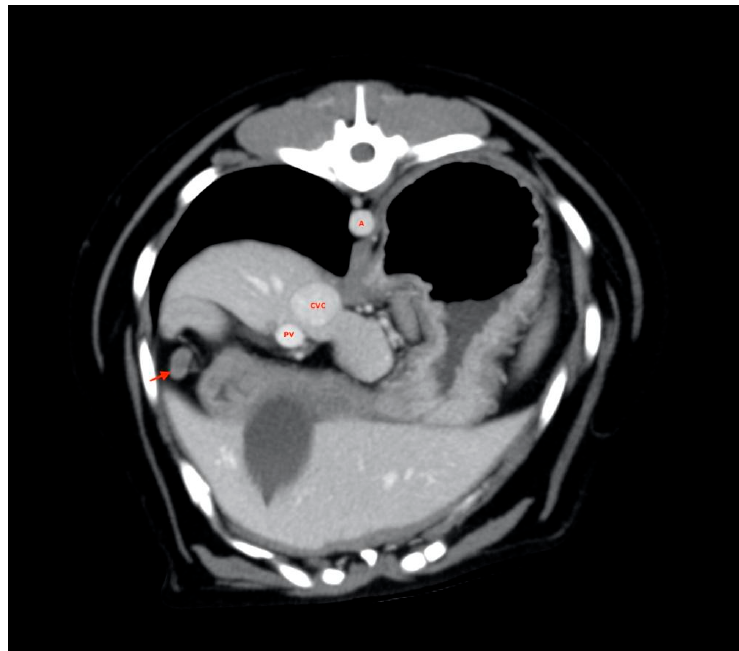
Figure 5. Pancreaticoduodenal lymph node (red arrow). A, aorta; CVC, caudal vena cava; PV, portal vein. At least two medial iliac lymph nodes were visualized and measured in each subject, one on the right and one on the left (Figure 6).